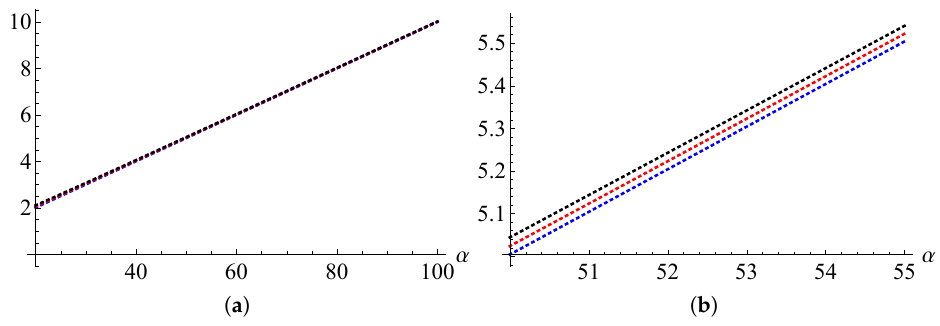
Figure 4. The critical velocity versus geometric parameter α when p = 0.04, k s = 0.01, ξ 1 = 0.5 under fixed boundary condition. Black dotted line, red dotted line and blue dotted line denote the results for k = 3,2,1 mode, respectively. ( a ) full graph, ( b ) enlarger partial of full